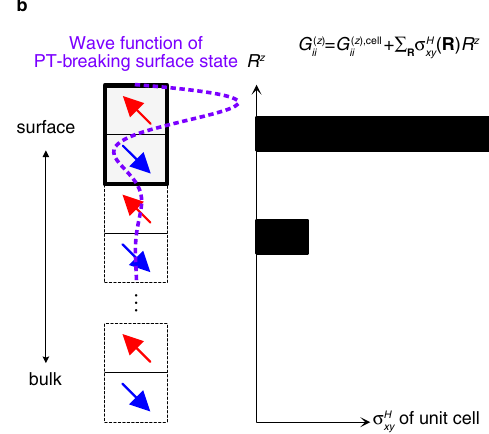
Fig. 2 | Intra-cell and unit-cell-position contributions to optical magneto- electric coupling. a Preferred choices of the unit cell with open boundaries. Arrows represent theaverage moment ofa layer,wherewebipartition the degrees offreedomwithintheunitcellintotheupperandlowerparts,eachofwhichde fi nes whatwecallalayer.Theleft-hand-sideandmiddleeven-layersystemsarerelatedby spatialinversionsymmetryandalsobythetranslationoftheblue-arrowlayersbya